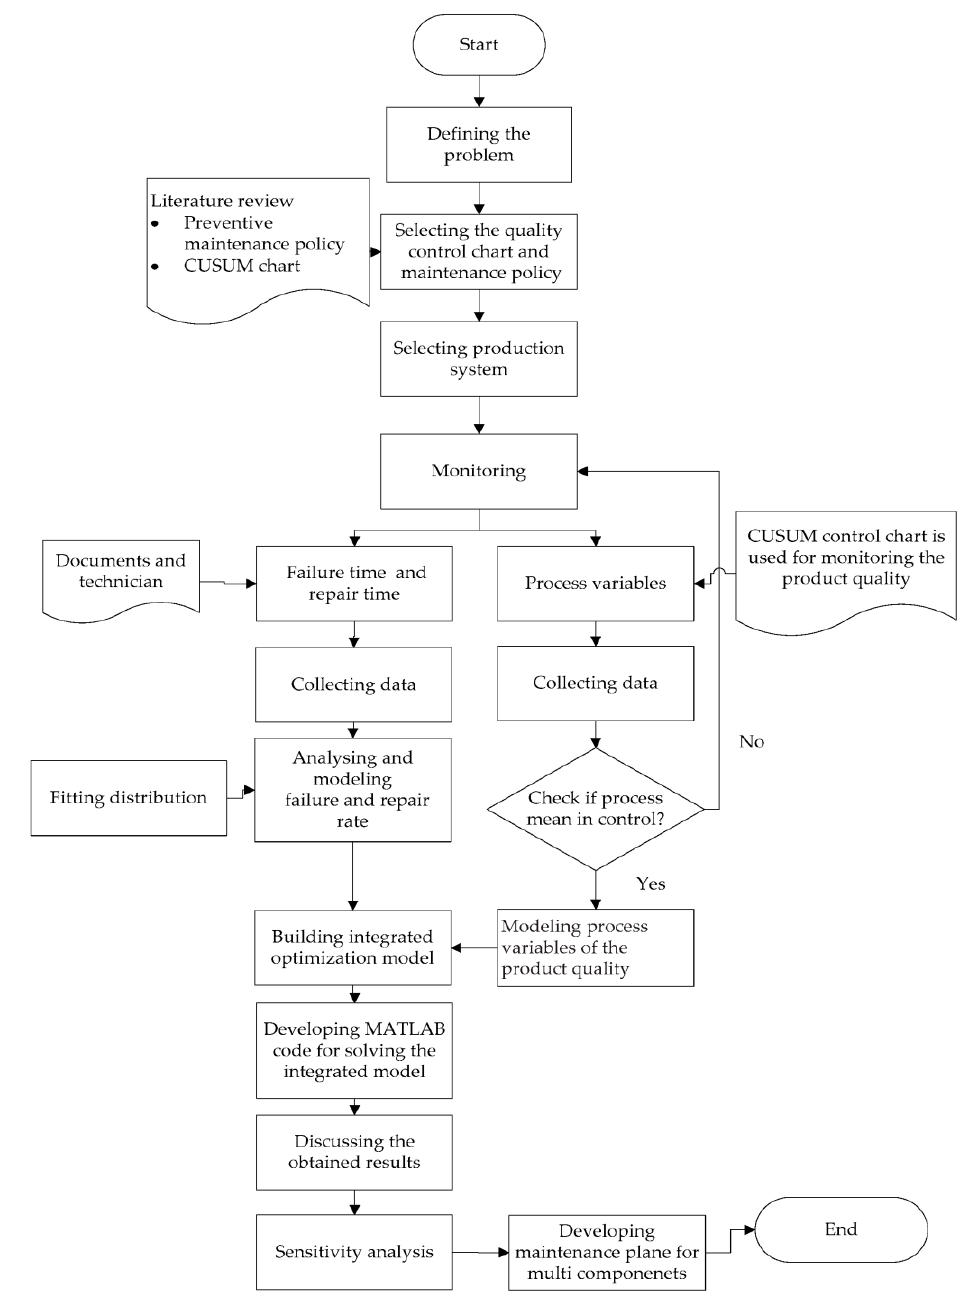
Figure 1. The workflow for the development of the integrated optimization model.